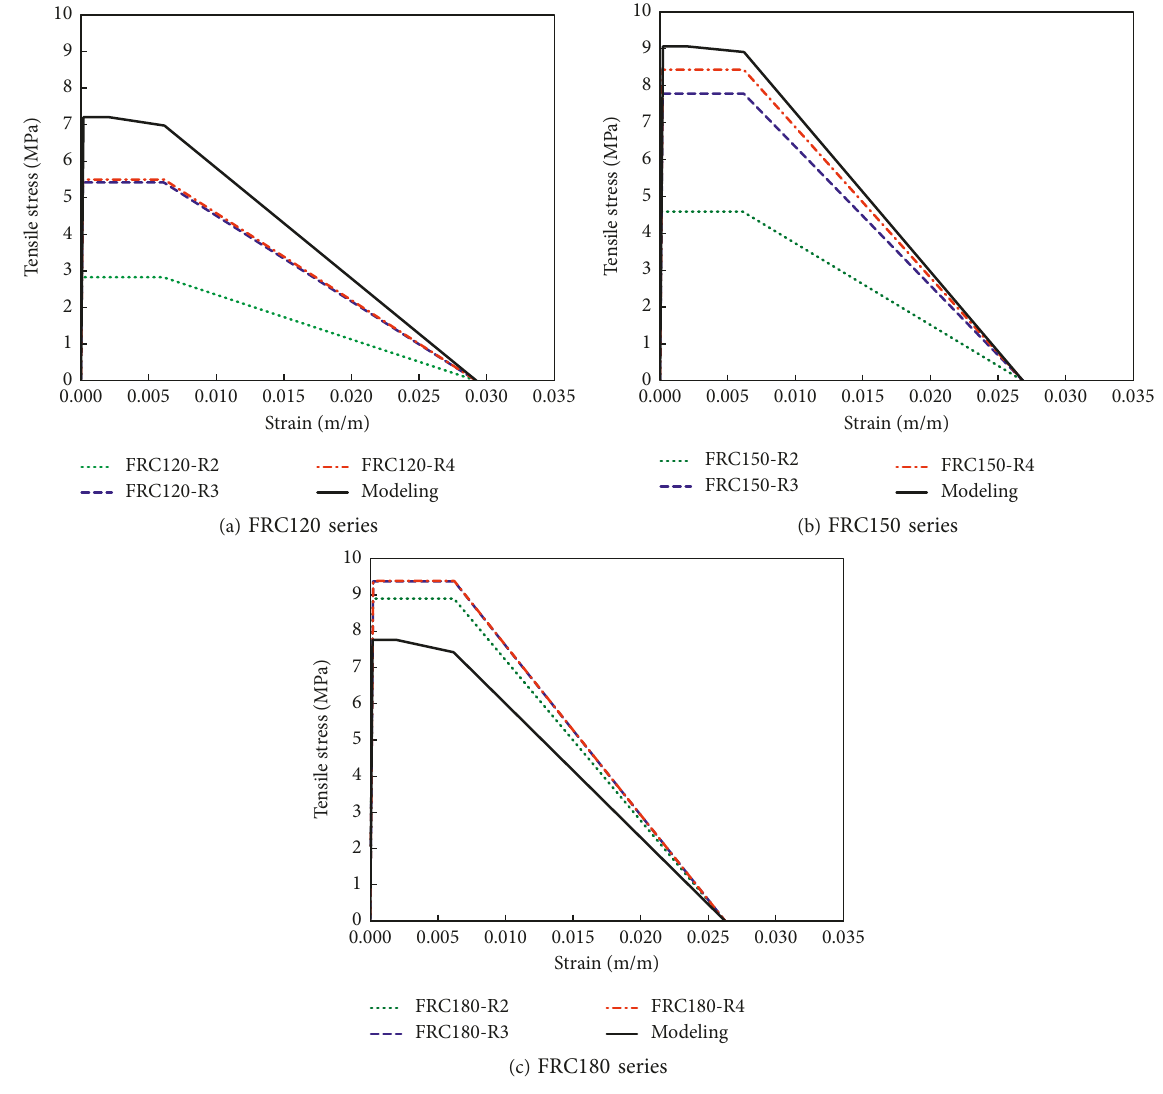
Figure 5: Modeling and estimation of the tensile behavior of UHPFRC.